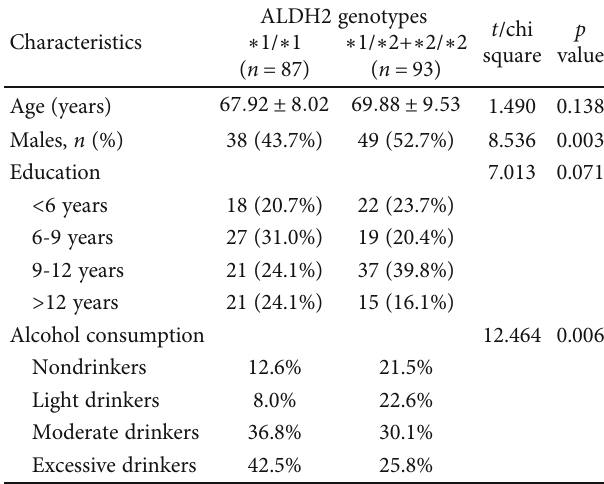
Table 1: Demographics of the study